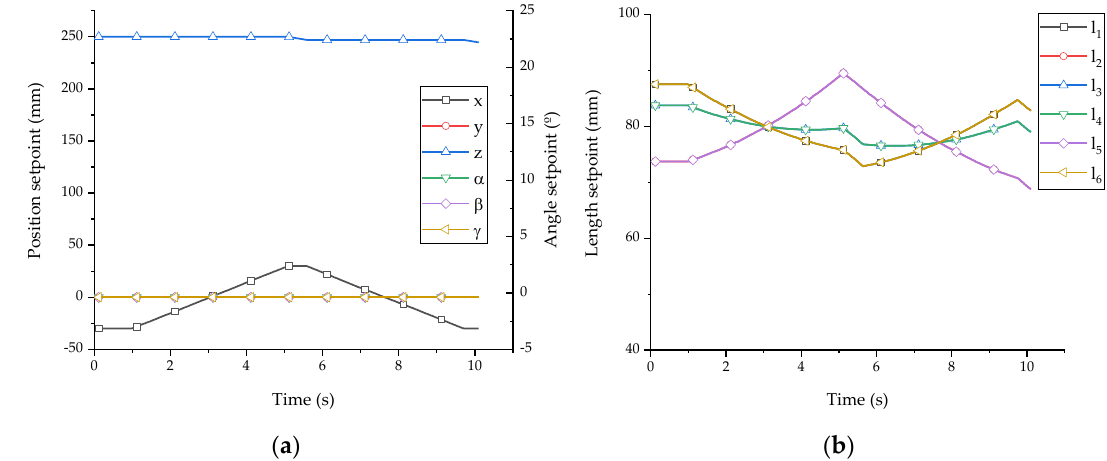
Figure7. Trajectoriesgraphs: ( a )Stewartplatformabsolutepositionandorientation( b Figure 7. Trajectories graphs: ( a ) Stewart platform absolute position and orientation ( b ) Actuator lengths.